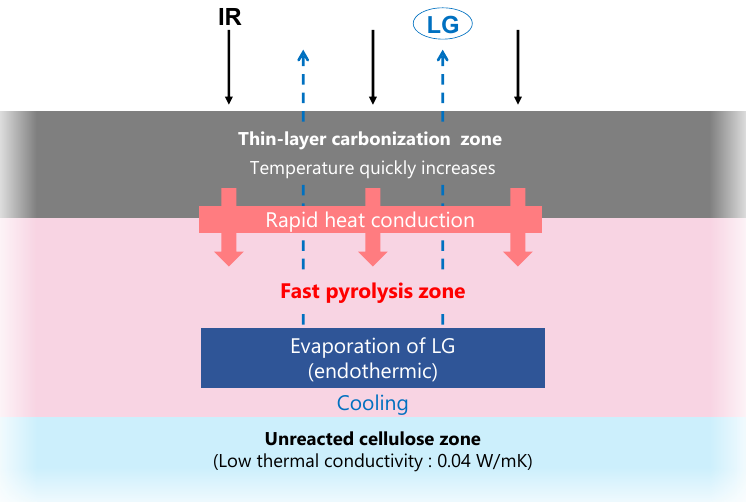
Figure 14. Physicochemical processes occurring in the pyrolysis zone, in which the thermal degra- dation of cellulose proceeds in a very narrow area near the carbonized layer.